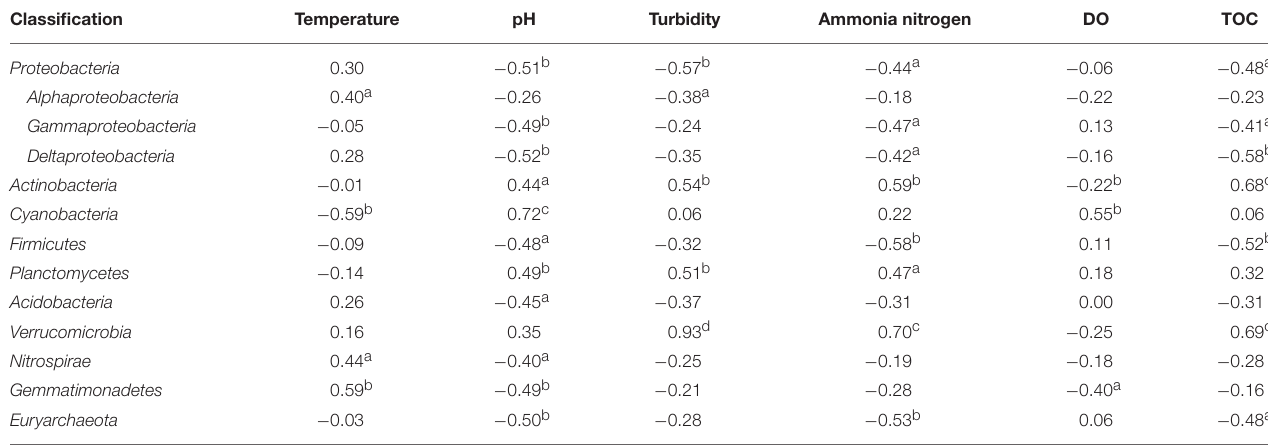
TABLE 3 | Correlations between the water quality parameters and the relative abundance of predominant bacterial phyla and proteobacterial classes.